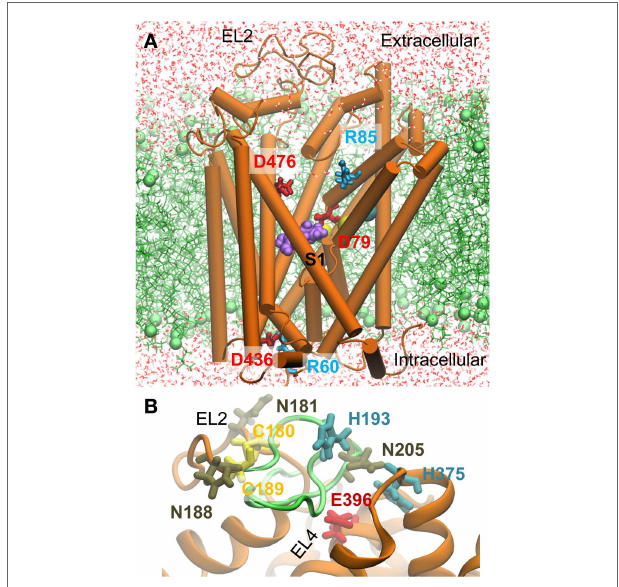
Figure 1 | Molecular dynamics (MD) setup for simulating the interaction of DaT with dopamine (Da), orphenadrine (OrPh), and amphetamine (aMPh) . (a) A representative hDAT conformation observed in simulations. The hDAT OF o structure (orange) constructed using homology modeling based on dDAT [PDB: 4M48 (33)] is embedded into a POPC lipid bilayer (green). The substrate DA (purple) is initially placed in the most favorable binding site indicated by docking simulations. Water molecules are displayed in red lines. The cyan and yellow spheres represent the Cl − and two Na + ions resolved in the crystal structure. Two oppositely charged pairs of residues, R85-D476 (extracellular, EC) and R60-D436 (intracellular. IC), function as the putative EC and IC gates (counterparts of R30-D404 and R5-D369 in LeuT). (B) A closeup view of the modeled EL2 loop. The region (S190 to P212) whose homologous counterpart was unresolved in the crystal dDAT structure is shown in green. The labeled residues shown in stick representation were used as probes for model assessment (see the